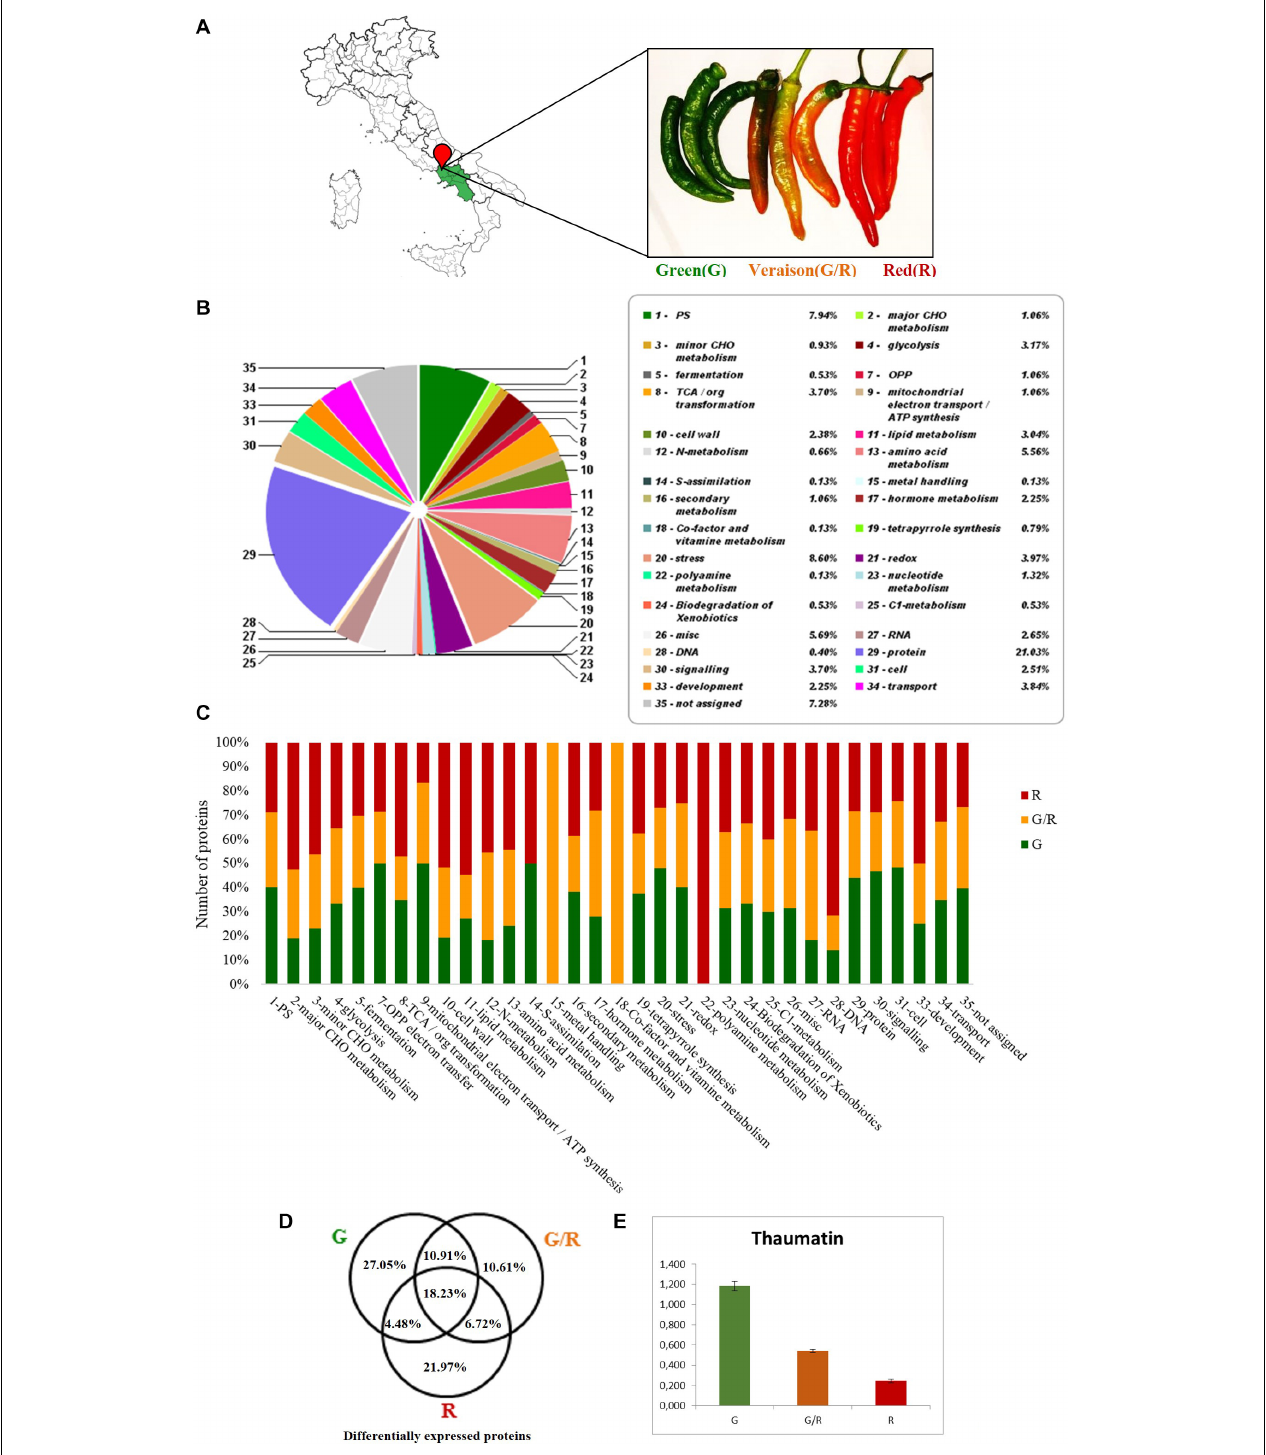
FIGURE 2 | (A) Friarielli "Sigaretta" variety collected in the three stages of ripening: green (G), green–red (G/R), ripe (R), used for the analyzes. (B) Proteins differentially expressed by percentage abundance of functional classes by Mercator4 V2.0 (https://mapman.gabipd.org/app/mercator). (C) Representative histogram of abundances by functional classes in the three stages of maturation. (D) Venn diagrams which represents the univocal or shared expression of the total of differentially expressed proteins. (E) Expression of Thaumatin protein (A0A1U8G8A9) in Friariello green–green/red–red samples.